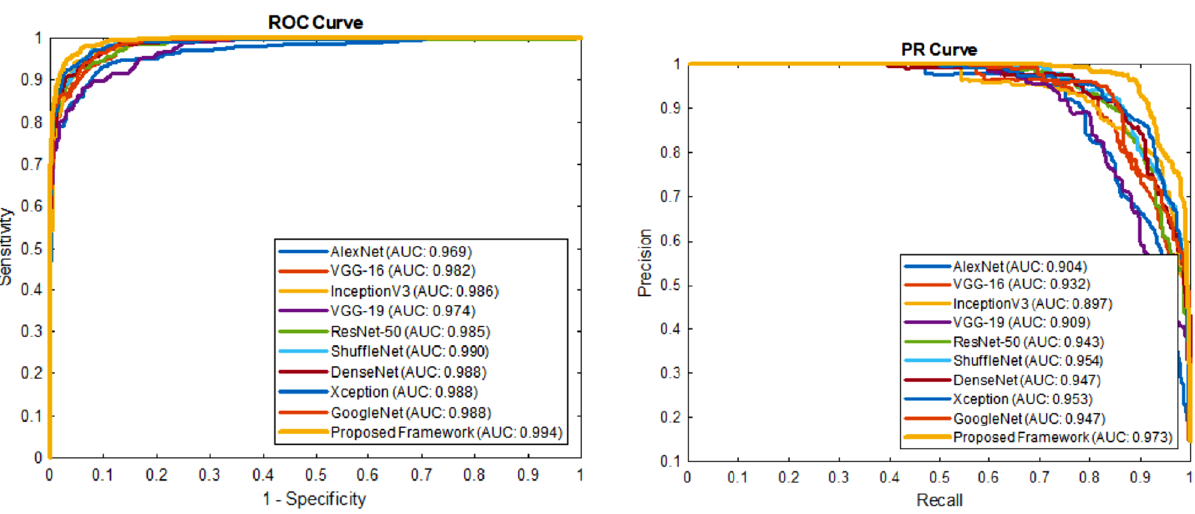
Figure 9. Detection rate analysis of the proposed iMDA in comparison with existing